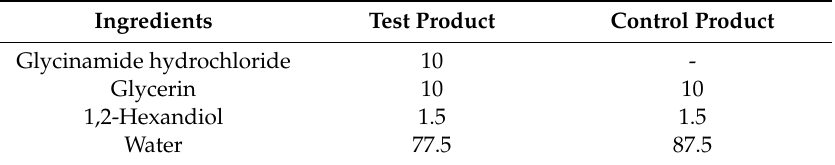
Table 1. Composition of test and control products (%, w / w